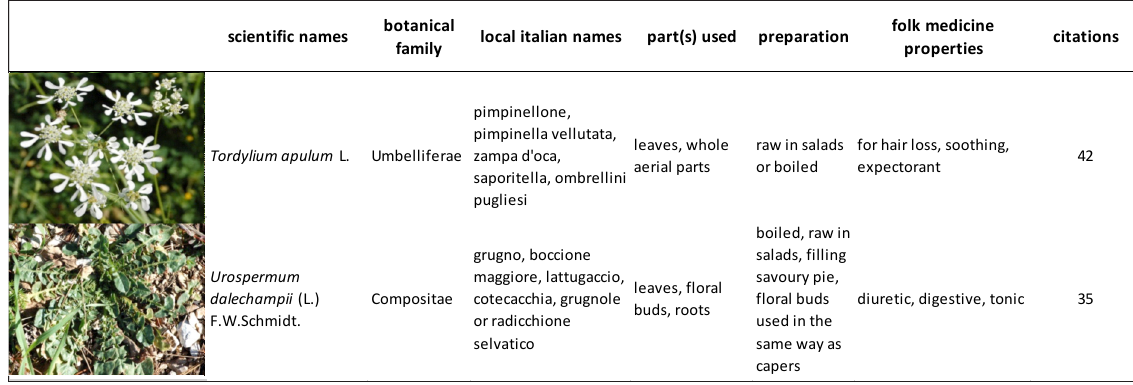
Fig. 2: The two edible wild plants analyzed. Local use, common names, parts used, preparation, some folk medicine properties and number of ad hoc semi- structured interview